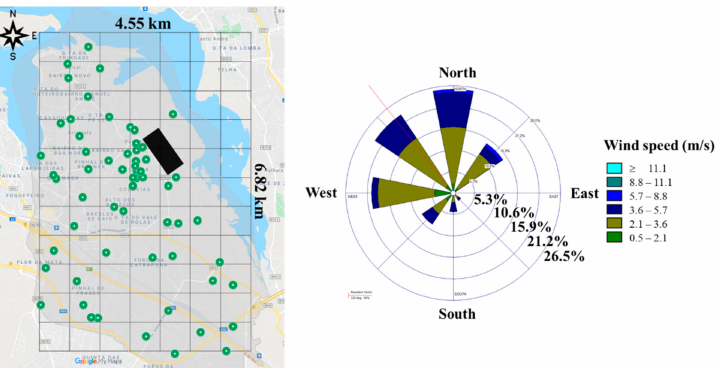
Figure 3. Grid of the spatial distribution of the transplanted and retrieved lichens after the exposure period (green dots) in the study area ( left ), with identification of the industrial area described before (black rectangle) (geographical data obtained from Google Earth Pro [30]), and ( right ) wind rose of the prevailing winds monitored in the weather station described in Section 2.3 (data obtained from the Portuguese Institute of Sea and Atmosphere, IPMA), during the exposure